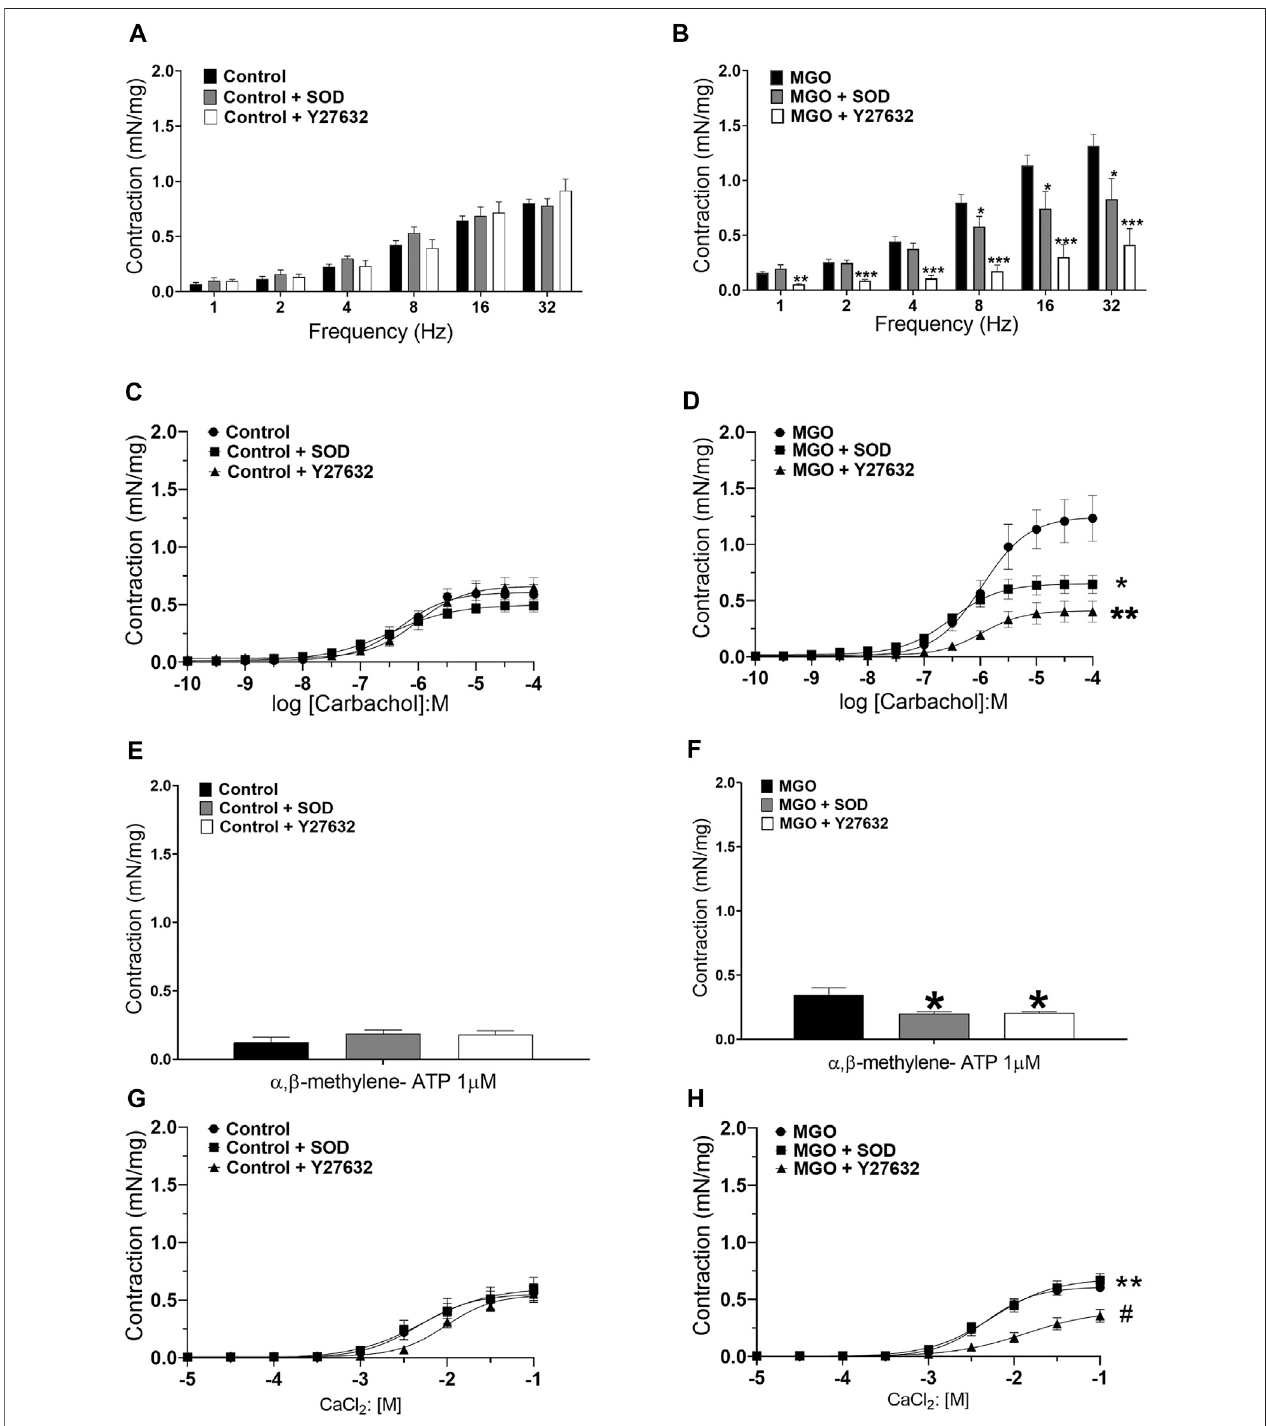
FIGURE 7 | Incubation of mucosa-denuded bladder preparations with superoxide dismutase (PEG-SOD; 87 IU/ml) or the Rho kinase inhibitor Y27632 (1 µM) reducestheenhanceddetrusorsmoothmusclecontractionsinmicetreatedwithmethylglyoxal(MGO)incomparisonwithcontrolmice.Panels (A,C,DandE) showsthe contractions induced by electrical- fi eld stimulation (frequency), carbachol, α , β -methylene-ATP (1 – 10 µM) and extracellular Ca 2+ in control mice, respectively. Panels (B,D,F and H) shows the contractions induced by the same stimuli in MGO-treated mice. Data are expressed as mean ± SEM ( n = 5-6 per group). * p < 0.05, ** p < 0.01, *** p < 0.001 compared with untreated preparations. # p < 0.05 compared with MGO + SOD group.